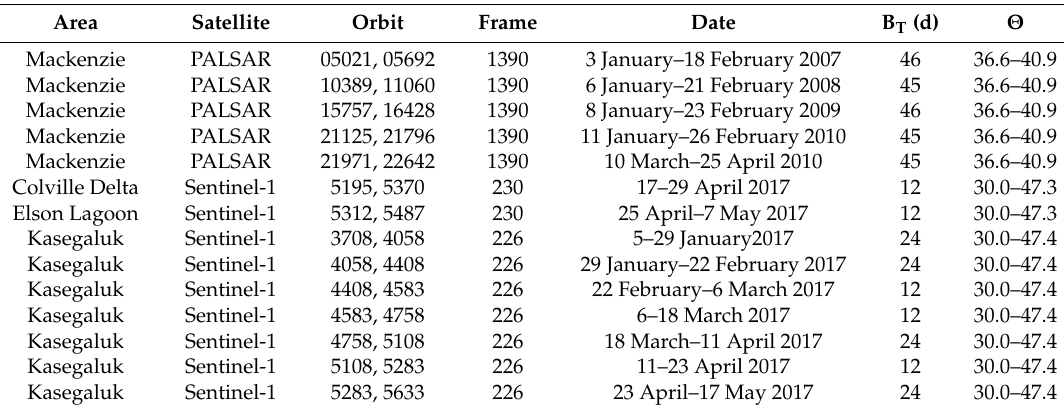
Table 1. Image data for the interferograms